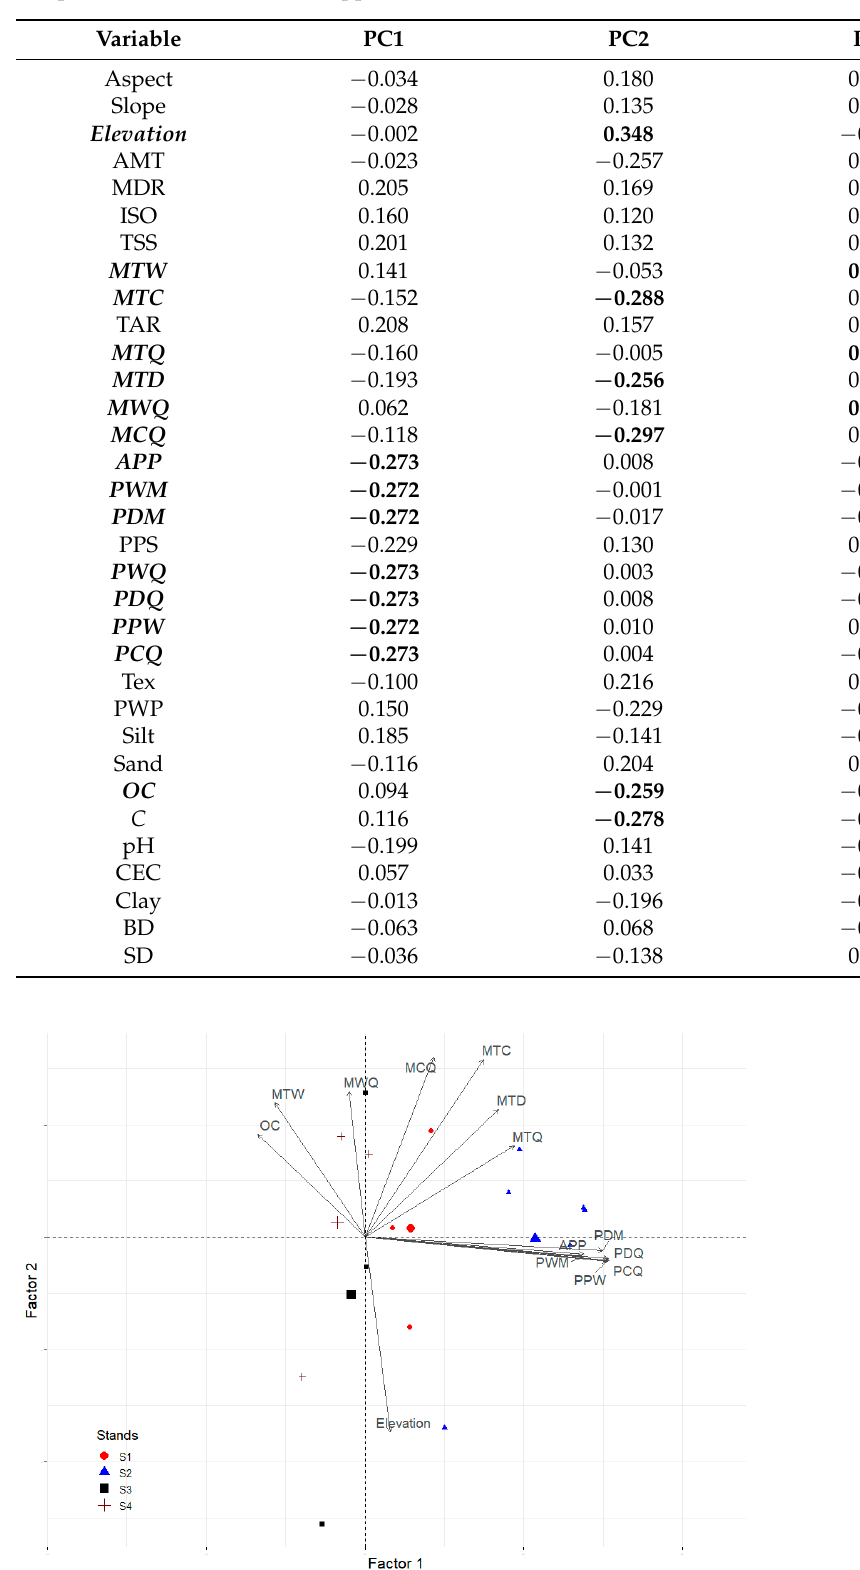
Table 3. Pearson correlation analysis ( r ) of environmental variables with the first three principal components (selected variables appear in italics and bold).